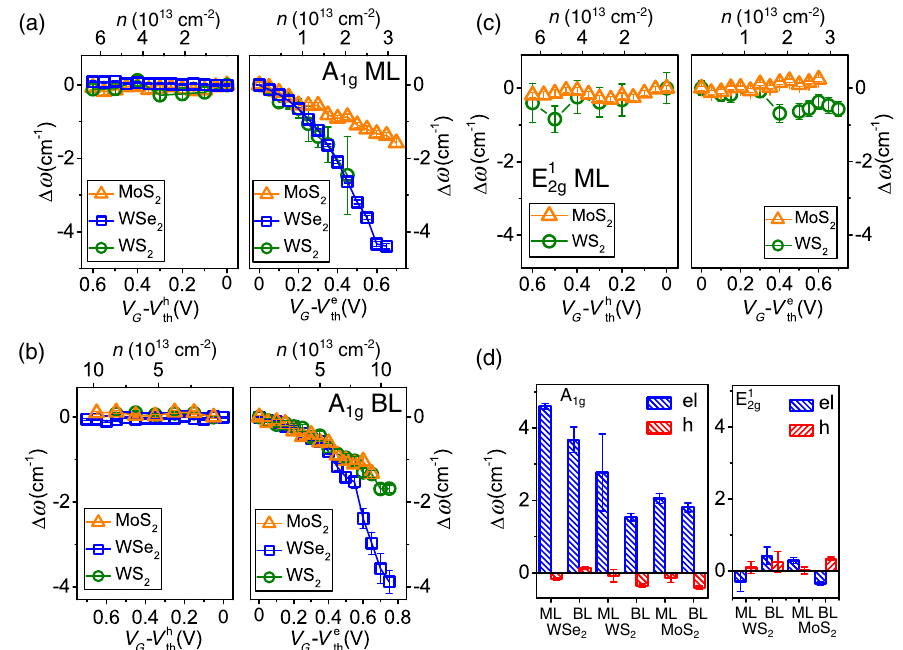
FIG. 3. (a) Shift Δ ω of the A 1 peak position in MoS 2 (orange open triangles), WSe 2 (blue open squares), and WS 2 (green open g circles) monolayers as a function of gate voltage (bottom axis), relative to the threshold voltage for hole accumulation (left panel) and for electron accumulation (right panel). The values of electron and hole density corresponding to the applied gate voltage — estimated using ¼ ð 1 =e Þ C j V − V e ; h j — is indicated on the top axis (the capacitance values are largely the capacitance of the ionic liquid gate, n e;h G th determined by the density of states, as discussed in Ref. [48]). The position of the Raman peak originating from the A 1 mode remains g unchanged for all TMD monolayers upon hole accumulation and shifts upon electron accumulation. (b) Same as panel (a) for the A 1 g mode of bilayers of the same TMD compound, MoS 2 (orange open triangles), WSe 2 (blue open squares), and WS 2 (green open circles). The trends and the order of magnitude of the frequency softening are identical in monolayers and bilayers. (c) The E 2 peak in g monolayer MoS 2 (orange open triangles) and WS 2 (green open circles) remains constant irrespective of the applied gate voltage (the left panel corresponds to hole accumulation and the right one to electron accumulation; for WSe 2 , the investigation of the E 2 mode is g prevented by the degeneracy with the A 1 mode). The same insensitivity of the E 2 mode to charge accumulation is seen in bilayers (not g g shown). (d) To summarize the effect of electron and hole accumulation on the softening of the A 1 and E 2 phonon modes, we compare g g the absolute shift of the peak position at the highest gate voltage value (relative to the corresponding threshold voltage) for all different j ¼ 0 . 6 V. The left and right panels summarize the values measured for the A investigated monolayer and bilayer TMDs, j V -V e ; h 1 g and G th E 2 modes, respectively, for either electrons (blue bars) or holes (red bars). It is clear from these plots that only the A 1 modes (with an g g out-of-plane motion component of the atomic displacement) are affected by introduction of carriers and only if electrons are